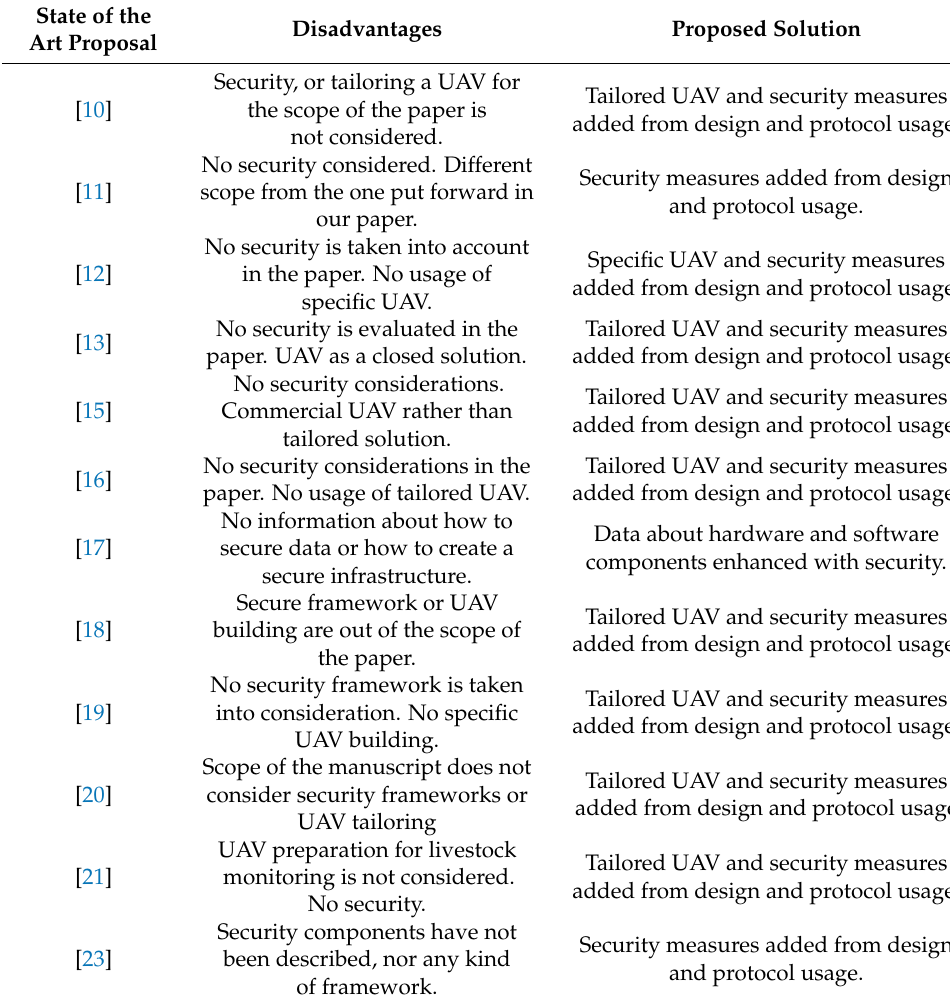
Table 3. Comparative analysis of the solution